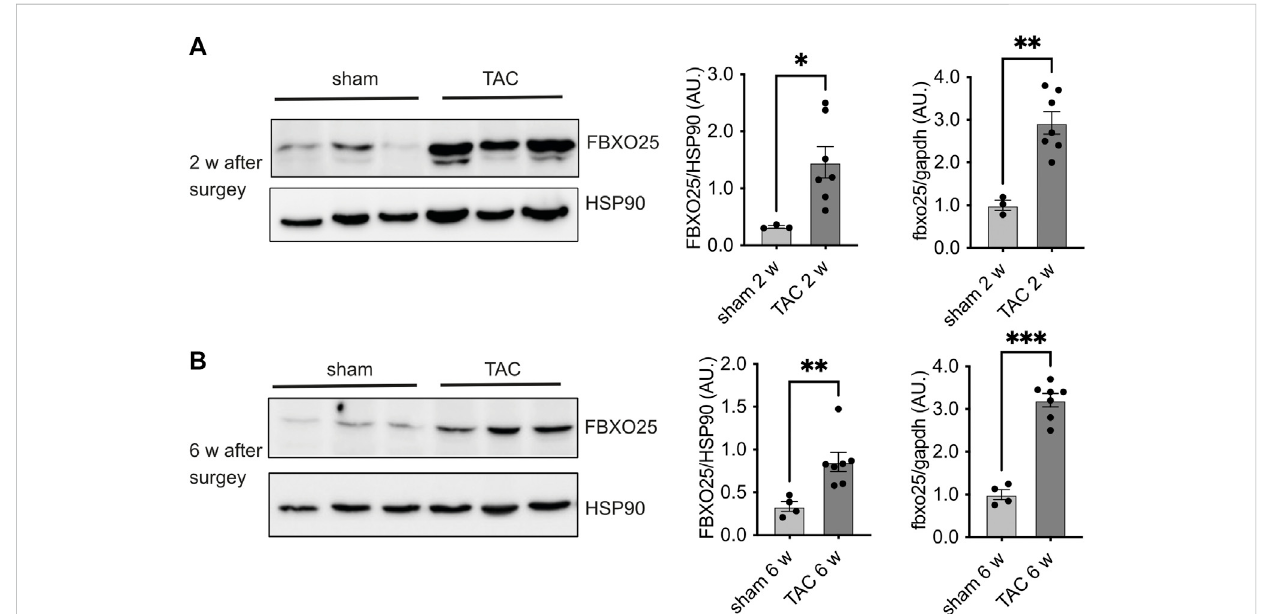
FIGURE 4 Fbxo25 accumulates in murine hearts upon transverse aortic constriction (TAC). Immunoblot of FBXO25 protein level, mRNA levels and quanti fi cation thereof in murine hearts lysates after two [upper panel (A) ] and 6 weeks [lower panel (B) ] upon TAC. HSP90 served as a protein loading control. Quanti fi cation of mRNA levels after two and 6 weeks (right panel) are normalized to control and gapdh served as housekeeping gene. Sham- operated littermates served as controls, N = 3 – 7. Histograms depict quantitative data (right panel). Statistical signi fi cance was determined